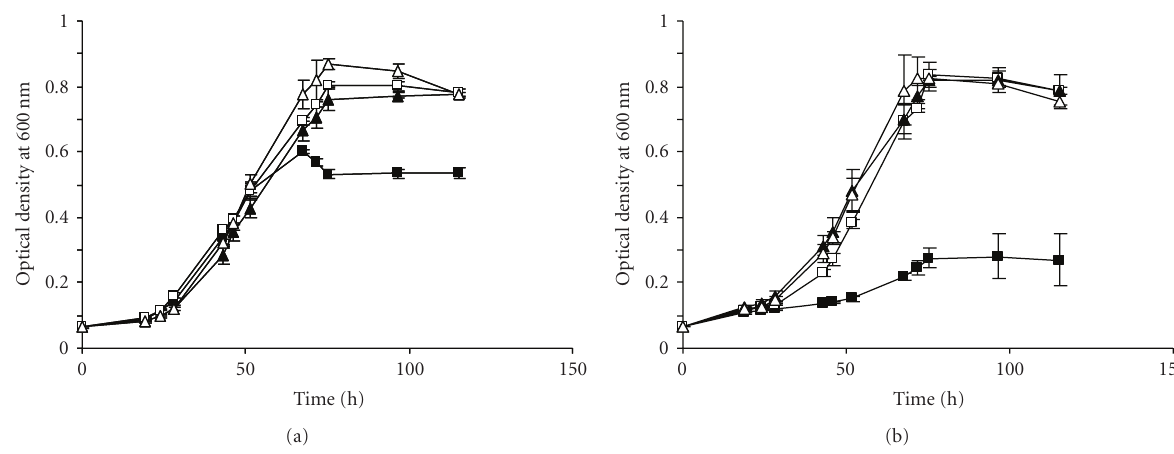
Figure 1: Growth analysis of M. mazei Δ hpt versus wild type in the presence of 8-ADP. Two di ff erent media were tested, (a) standard minimal medium [18] and (b) minimal medium with significantly reduced yeast extract (0.5 g/L). M. mazei strains were grown in 50 mL of the respective medium complemented with 150 mM methanol as carbon source under a gas atmosphere of N 2 /CO 2 (80:20). Strains were incubated without additives (open symbols) or in the presence of 20 μ g/mL 8-ADP (closed symbols). Squares: wild type; triangles: M. mazei Δ hpt. Standard deviations of three replicates for each strain are